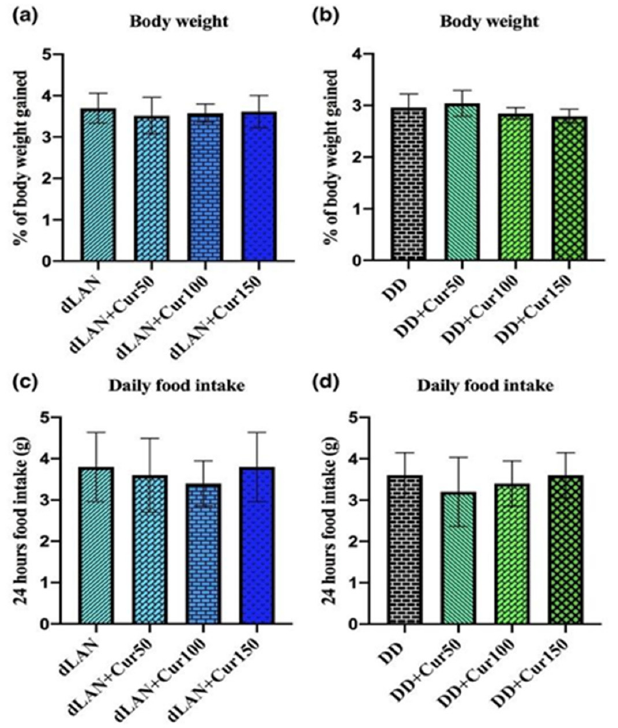
Figure 2. Effect of different concentrations (50, 100, and 150 mg/kg) of orally administered curcumin (Cur) on ( a ) the percentage of body weight gained in dim light at night (dLAN), ( b ) percentage of body weight gained in complete darkness (DD), ( c ) food intake in dLAN, and ( d ) food intake in DD-exposed mice. Values are represented as mean ± standard deviation ( n = 5). Non-parametric one-way ANOVA with post-hoc Dunnett’s test was employed to differentiate the results among different treatment groups. All the data were analyzed with GraphPad Prism-8 software.